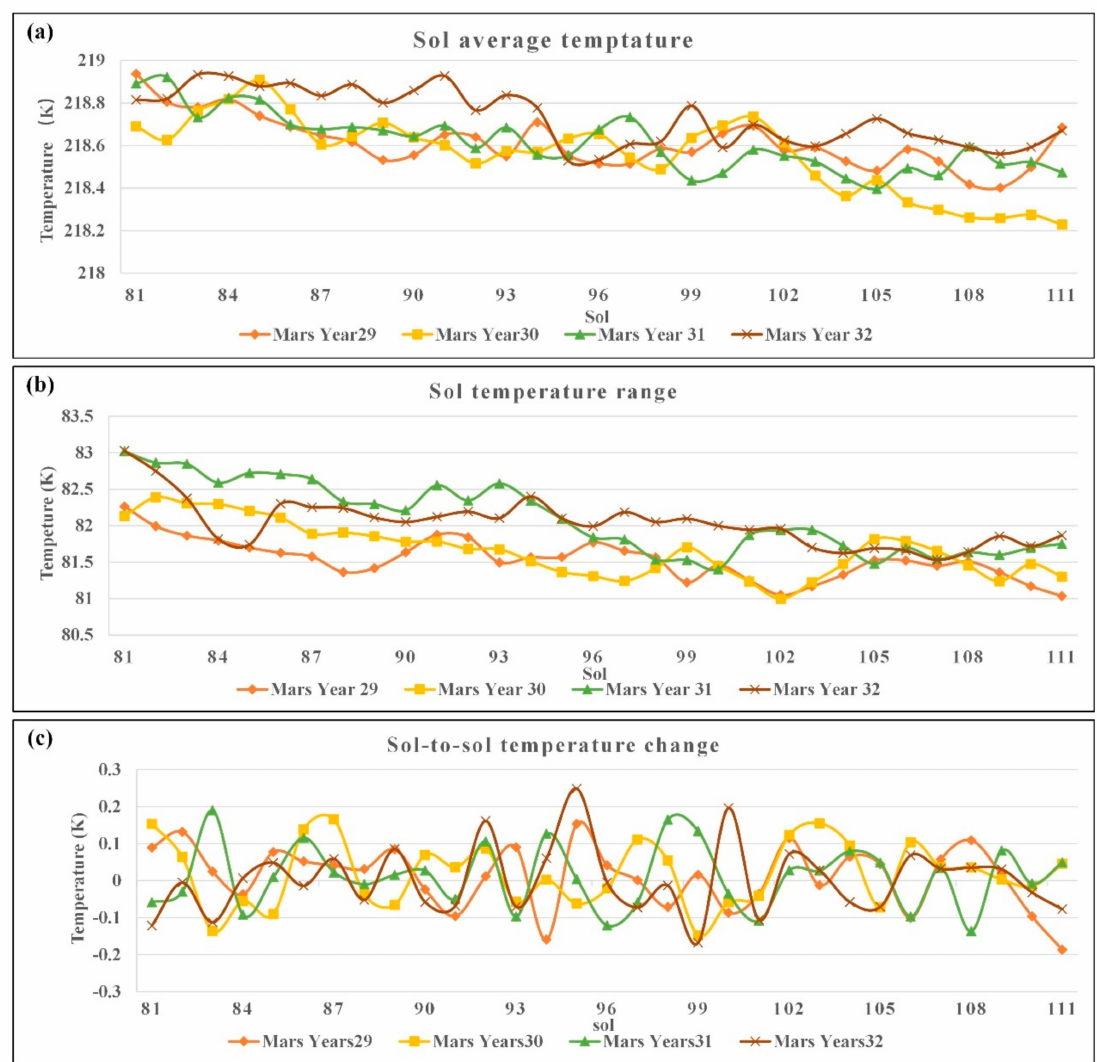
Figure 4. The change in sol average temperature (SAT), sol temperature range (STR), and sol-to-sol temperature change (STC) over time during the period sol 81–111 in Martian years